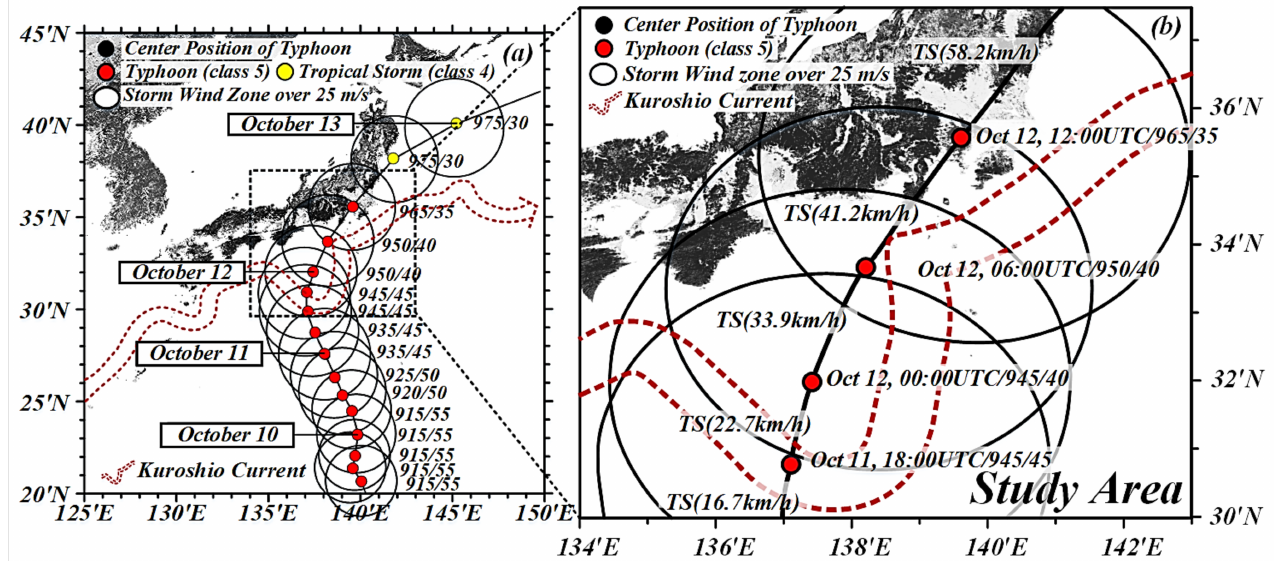
Figure 1. Six-hourly HAGIBIS best track on 9–13 October 2019 obtained by JMA and daily Kuroshio current meander (KCM; red dotted line) provided by JCC ( a ) at the wide area; including the typhoon central location with intensity (dots in red to yellow), the radius of the storm wind zone (SWZ; black circles), date (month/day), and central pressure (hPa)/maximum sustained wind speed (m/s), and ( b ) at the boundary of the study area; including same components as ( a ) and adding time (UTC) and translational speed (TS; km/h),